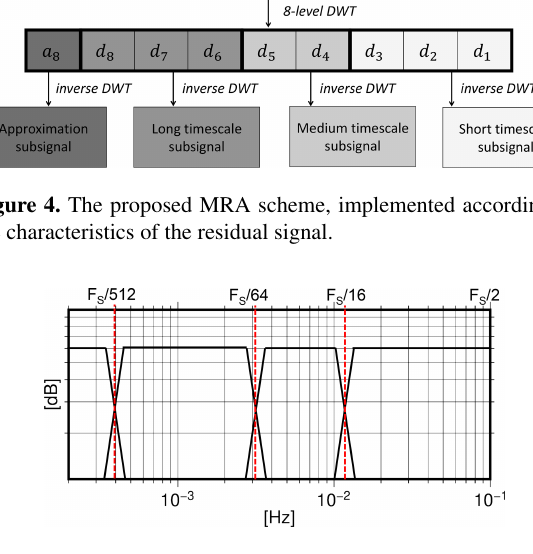
Figure 5. The proposed MRA bandwidth division of the residuals with frequency sampling F S of